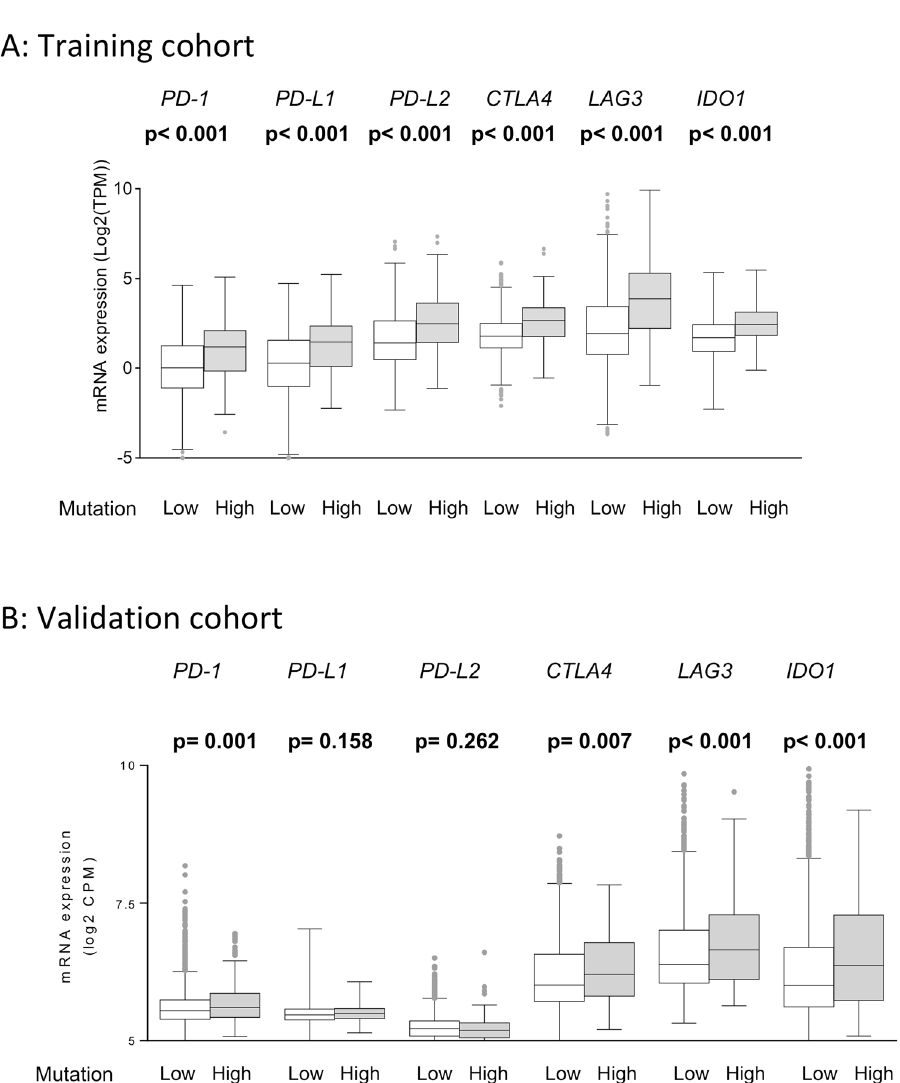
Figure 7. ( A ) High mutation rates correlated with significantly higher expression of T cell exhaustion markers, including PD-1, PD-L1, PD-L2, CTLA4, LAG3, and IDO1 (all p < 0.001) in the training cohort. ( B ) High mutation rates were similarly associated with significantly higher expression of PD-1 (p = 0.001), CTLA4 (p = 0.007), LAG3 (p < 0.001), and IDO1 (p < 0.001) in the validation cohort. PD-1, programmed cell death